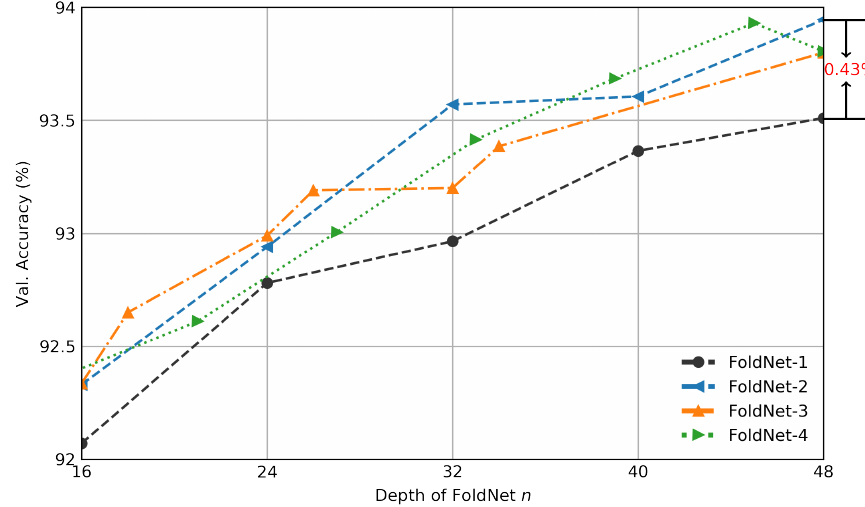
Figure 5. Validation accuracy of FoldNet- d for CIFAR-10 dataset when hidden dimension h = 64. x axis is the depth of neural network n ; y axis is the validation accuracy percentage. The validation accuracy of FoldNet-2 increases by 0.43% compared with FoldNet-1 when depth n =